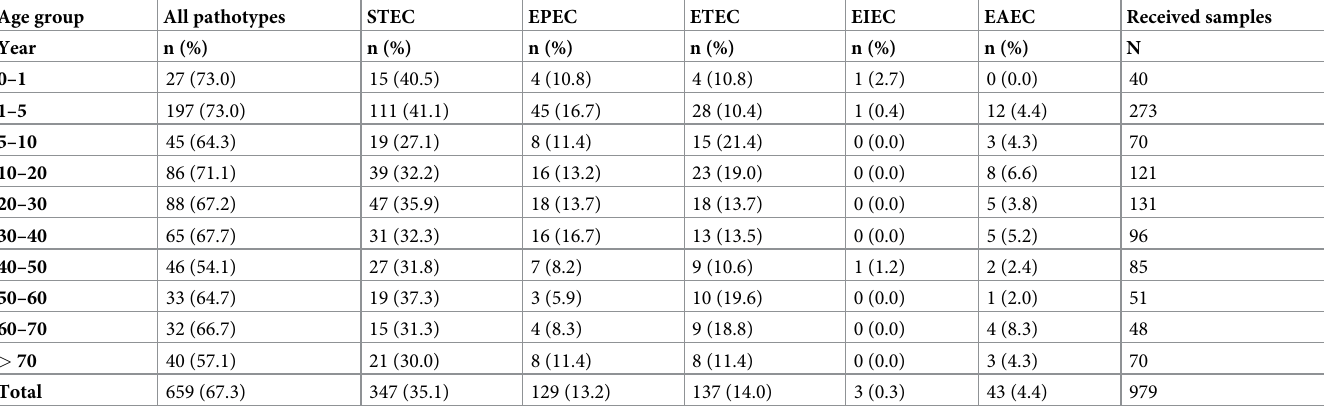
Table 3. Age-specific frequency of E . coli pathotypes in 979 E . coli -positive culture samples received from 15 provinces of